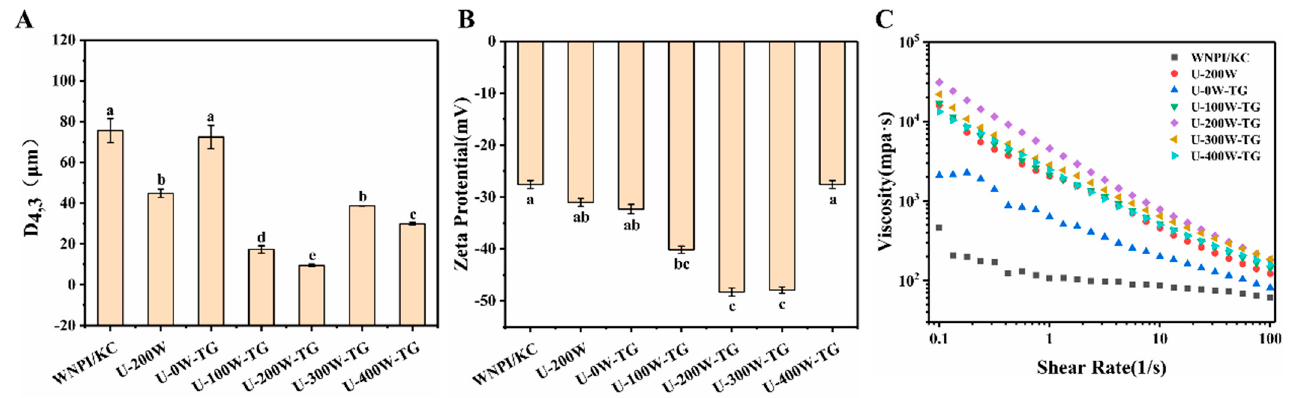
Figure 4. Effects of ultrasonic power on D [4,3] ( A ), zeta potentials ( B ) and apparent viscosity ( C ) of WNPI-KC composite gels. Different letters indicate significant differences ( p < 0.05).